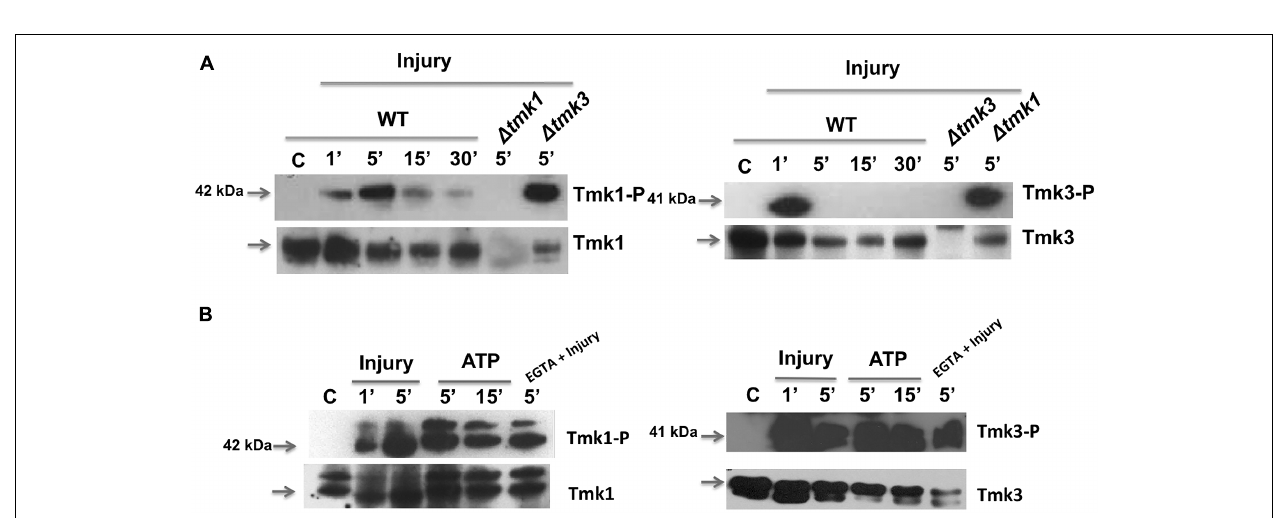
control. (B) Quantification of conidia produced after injury for each strain. Error bars represent the mean ± SEM of three biological replicas. Bars with different letters indicate treatments that were significantly different ( P < 0.001).